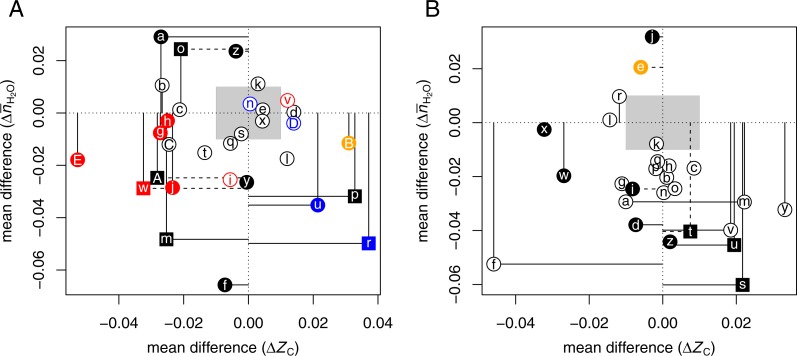
Compositional analysis of differential protein expression in (A) hypoxia or 3D culture and (B) hyperosmotic stress.The plots show differences (Δ) between the mean for up-expressed and the mean for down-expressed proteins of average oxidation state of carbon (ZC) and water demand per residue (\documentclass[12pt]{minimal}
\usepackage{amsmath}
\usepackage{wasysym}
\usepackage{amsfonts}
\usepackage{amssymb}
\usepackage{amsbsy}
\usepackage{upgreek}
\usepackage{mathrsfs}
\setlength{\oddsidemargin}{-69pt}
\begin{document}
}{}${\bar {n}}_{{\mathrm{H}}_{2}\mathrm{O}}$\end{document}n ¯H2O) for each dataset from Tables 3 and 4. Red, blue, and orange symbols are used to highlight datasets for tumorspheres, reoxygenation or anti-hypoxic treatment, and adipose-derived stem cells, respectively.